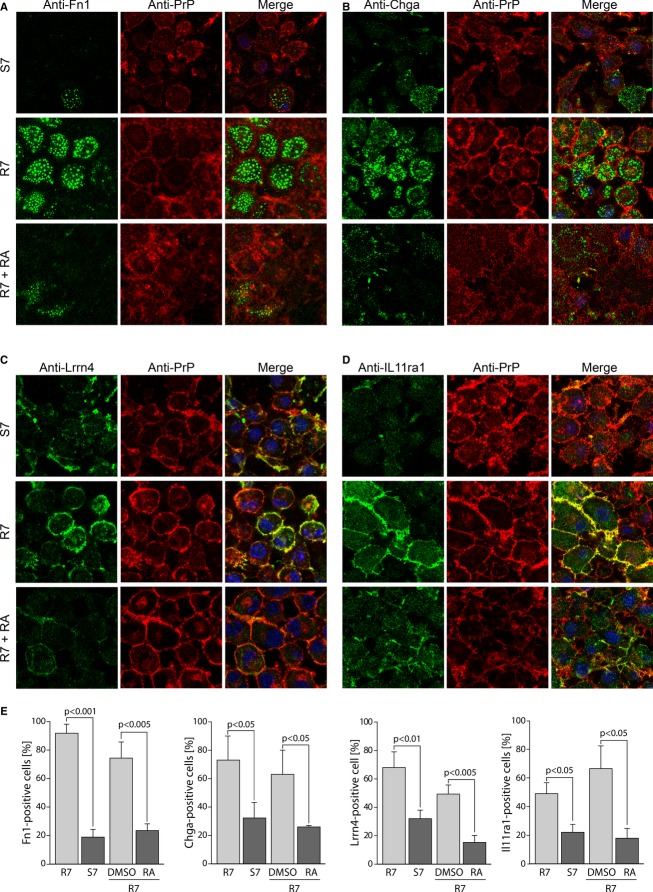
Prion modifiers are expressed at the extracellular matrix and plasma membrane levelA–D Representative images of fixed and permeabilised cells labelled with antisera against (A) Fn1, (B) Chga, (C) Lrrn4, and (D) Il11ra1. Images for Lrrn4 (C) were collected at mid-cell level, all other images at ECM level. Differences in protein expression levels between S7, R7 cells and R7 cells in presence of RA, respectively, are shown and are in agreement with gene expression data (Fig2).E The relative abundance of cells positive for Fn1, Chga, Lrrn4, and Il11ra1 in susceptible S7 and revertant R7 cells, in presence and absence of RA, analysed using Volocity image analysis software as described in Methods are shown. Mean numbers ± SD for 20 frames are shown. The degree of colocalisation between candidate proteins and PrP was determined in R7 cells and is represented as Pearson's correlation coefficients (PCC): (A) 0.11 ± 0.04, (B) 0.20 ± 0.12, (C) 0.55 ± 0.09, and (D) 0.36 ± 0.14.